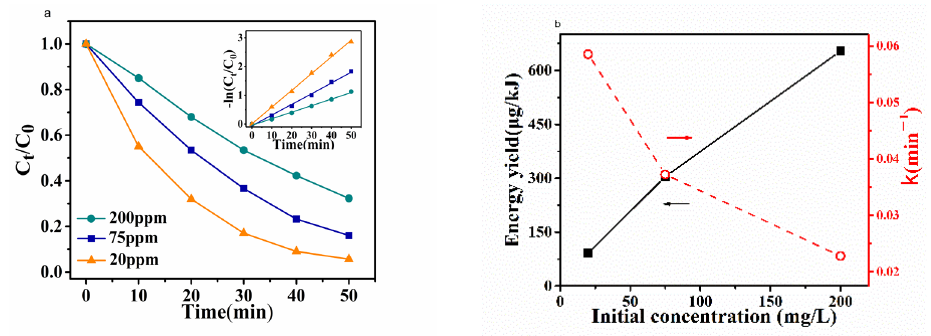
Figure 3. ( a ) degradation of PFOA with various concentrations of PFOA. Inset shows the first-order degradation kinetics curves of PFOA under Ar-plasma treatment. (The lines were fitted results). ( b ) energy yield and kinetic constant at different concentrations. The experimental conditions: negative pulse power supply, peak voltage: 13 kV, power frequency: 6 kHz, pulse width: 500 ns; Ar plasma; average power: 26 W.